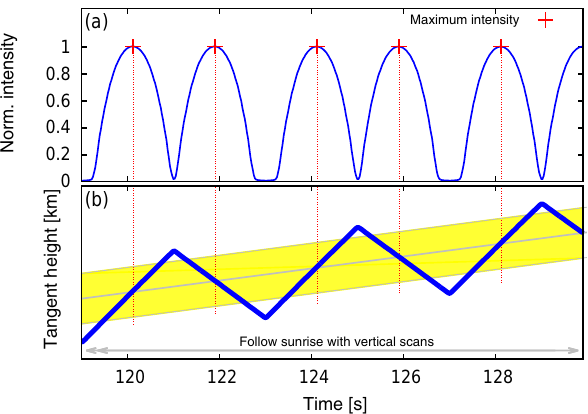
Figure 5. Moon over limb port measurement sequence. The moon is tracked for 2s with the SFD in both elevation and azimuth direction. The following scans over the lunar disk are not used